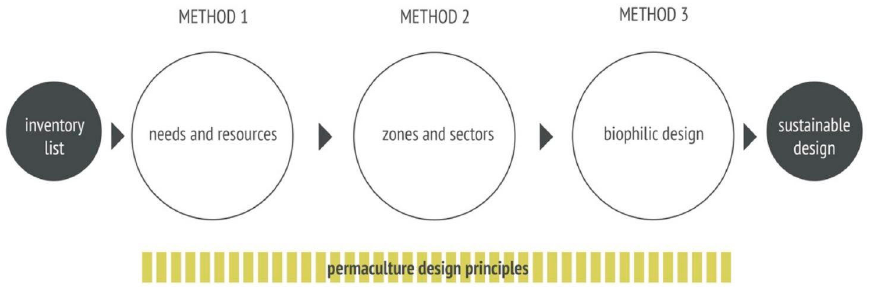
Figure 4. Permaculture design guidance towards mental health and environmental sustainability (Source: compiled by the author).